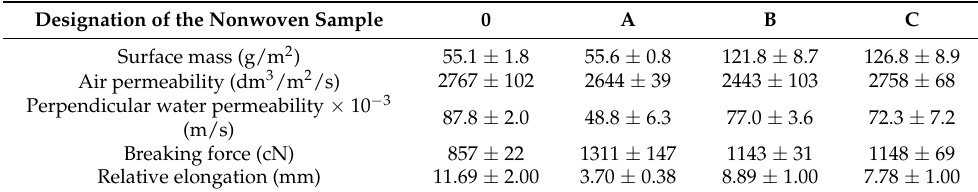
Table 2. Physicochemical parameters of the obtained